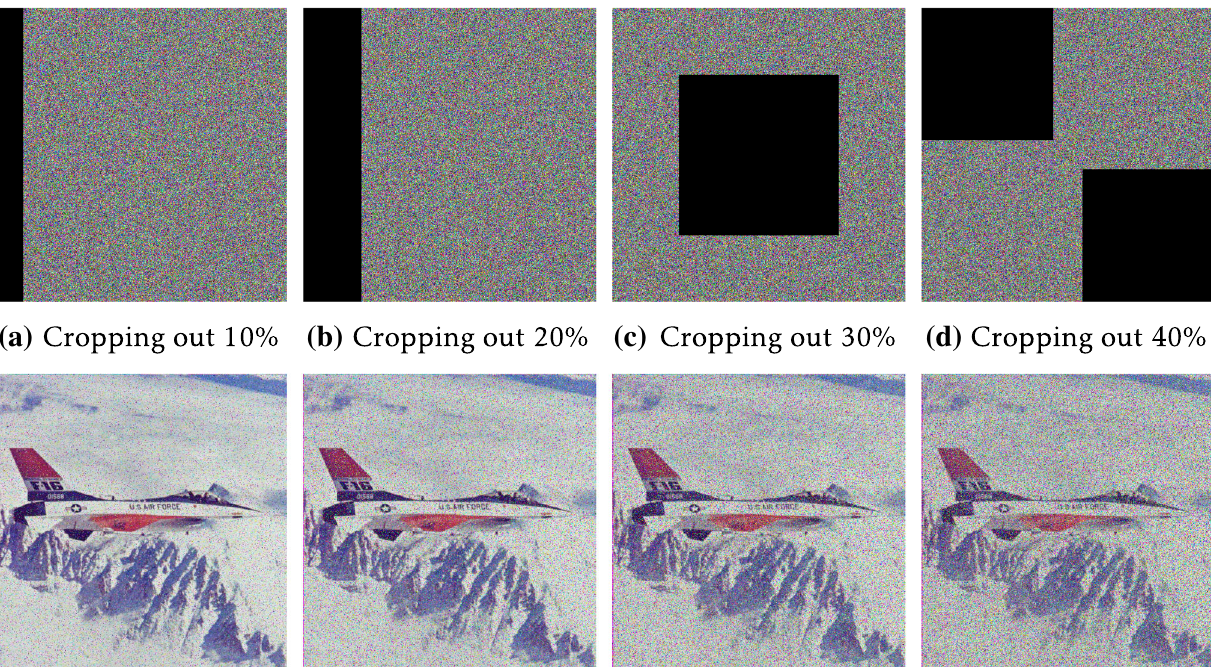
Fig. 9 Occlusion attack, in which the top row implies the defective encrypted images by cropping out some data and the bottom row shows the equivalent decrypted images